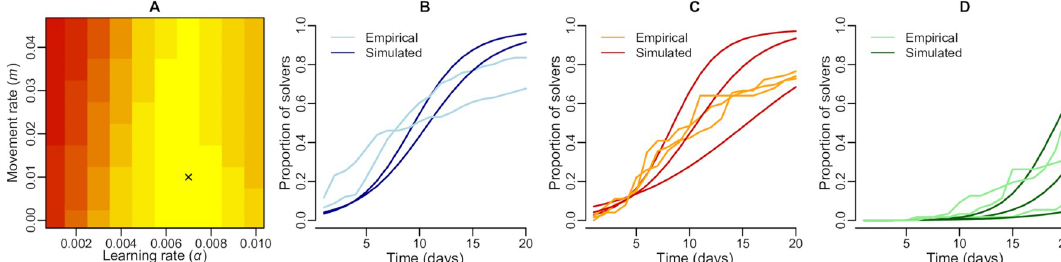
Fig 3. Scan of parameter space and model calibration. A: Scan of parameter space over the learning rate α and the movement rate m . The darker red colours indicate higher sum of squares between empirical and simulated diffusion curves. The black cross indicate the parameter values generating the lowest sum of squares between empirical and simulated diffusion curves, thus indicating the model that is best able to replicate these diffusion curves (i.e. best-fit model ). B: Empirical and simulated (for the best-fit model) diffusion curves over 20 days for the sub-populations in which solvers using solution s 2 where initially released; C: Empirical and simulated (for the best-fit model) diffusion curves over 20 days for the sub-populations in which solvers using solution s 1 where initially released; D: Empirical and simulated (for the best-fit model) diffusion curves over 20 days for the control sub-populations in which no trained solvers where initially